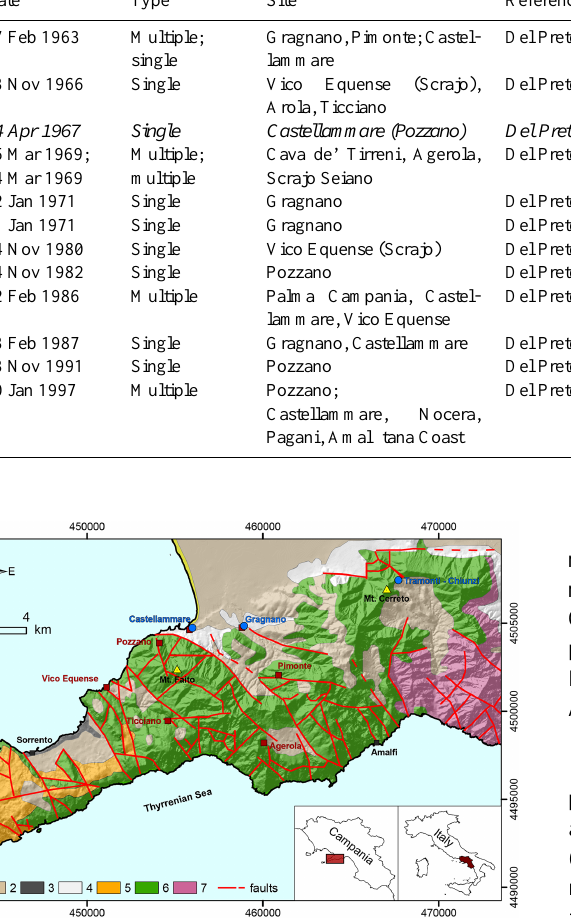
Table 1. Dates of activation of the shallow landslides in the Sorrento Peninsula. Key: date: day of occurrence; type: widespread (multiple) or few (single) activation; site: municipality including the affected location; period employed: dates used for calibration (except for no. 11); rank: relative position of the corresponding maximum of the mobility function obtained by calibration. An asterisk marks the date employed for validation. In italics, the activation date (no. 0) excluded due to hydrological constraints. No.